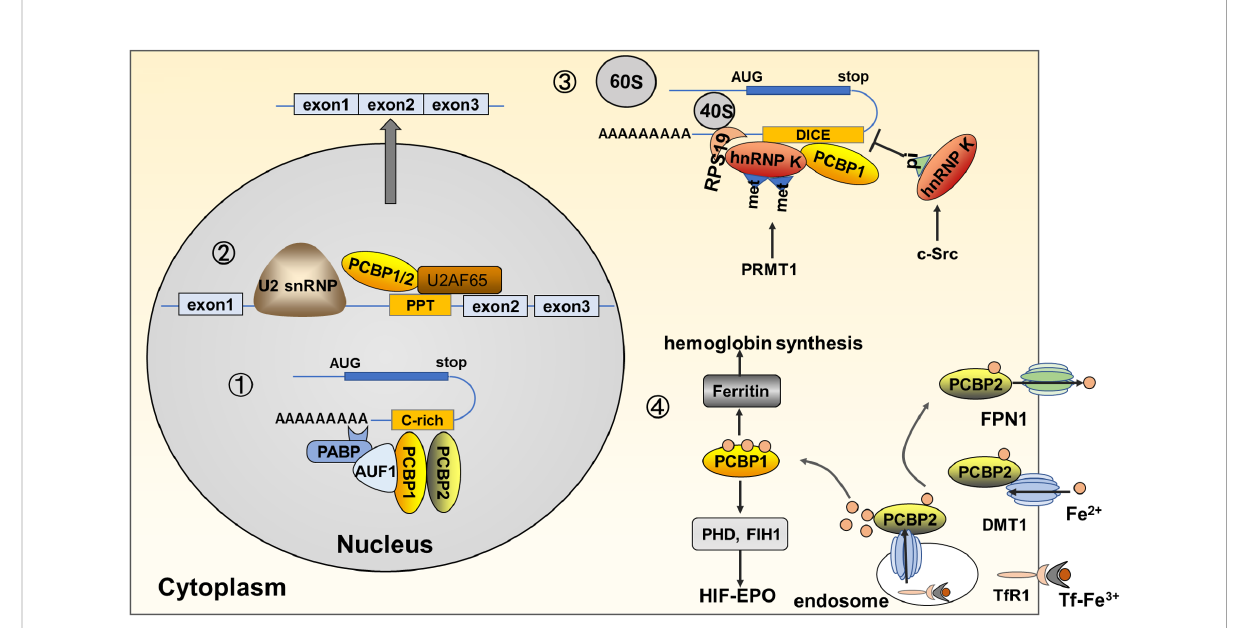
FIGURE 2 Functions and molecular mechanisms of PCBPs in erythropoiesis. (1) PCBPs bind directly to pre-mRNA 3 ’ UTR and partner with other proteins, such as AUF1, and PABP, to regulate the stability of target mRNAs, such as a / b -globin and EPO. (2) PCBPs bind to the PPT region located 5 ’ to the PCBP-enhanced exonic segment, together with other spliceosome components, including U2AF65, and U2 snRNP, to induce the alternative splicing of mRNAs, such as protein 4.1R and RUNX1. (3) PCBPs inhibit mRNA translation via binding to 3 ’ UTR, precluding 80S ribosome assembly. For example, hnRNP K binds to DICE in ALOX15 mRNA, interacting with RPS19 located at the head of the 40S subunit, inhibiting the 60S subunit from joining the 40S subunit. Post-translational modi fi cations on hnRNP K in fl uence its binding activity; for example, asymmetric demethylation by PRMT1 augments its interaction with RPS19, while phosphorylation of Tyr 458 in KH3 by c-Src dimmish its DICE-binding activity. Other genes of PCBPs mediated mRNA translation repression genes include c-Src, and NMHC IIA; (4) PCBPs act as iron chaperones regulating the cytosolic iron level and mediating hemoglobin synthesis and iron-dependent enzyme activity. PCBP2 directly mediates ferrous iron uptake and export via protein-protein interaction with transmembrane DMT1 and FPN1. PCBP2 also transfers ferrous iron in the cytoplasm endosome. Tf-TfR1mediates ferric iron uptake, and in the formed endosome, deoxidized ferrous iron is transferred by DMT1 to PCBP2. PCBP1 behaves as the main protein to transfer ferrous iron to target molecules via protein-protein interaction; for instance, PCBP1 transfers iron to ferritin, mediating iron storage and release for hemoglobin synthesis; PCBP1 transfers iron to PHD and FIH1, iron-dependent proteins regulating HIF a